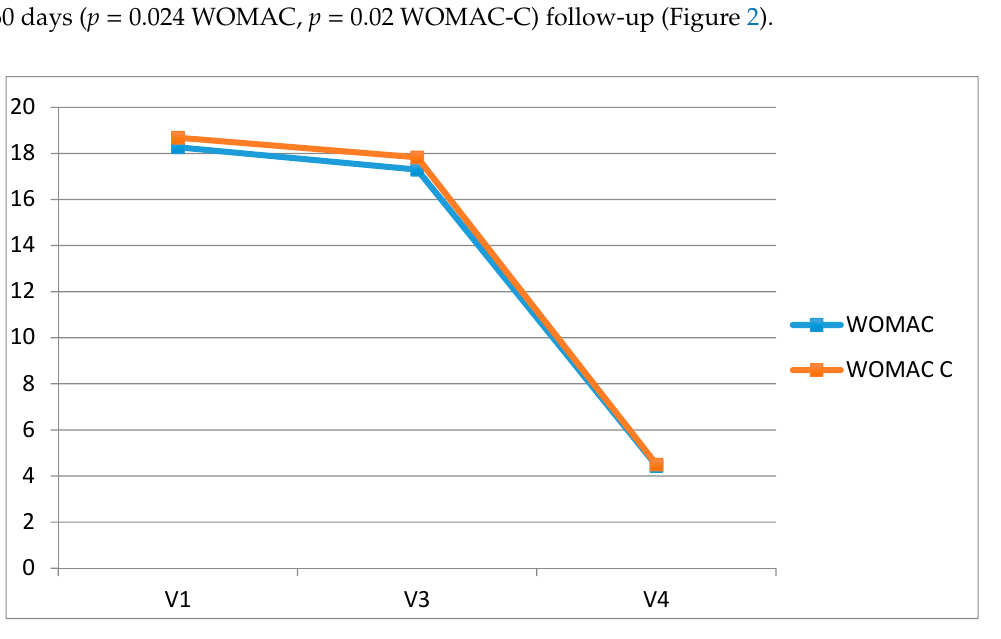
Figure 2. The Western Ontario and McMaster Universities Osteoarthritis Index (WOMAC) score and physical function subscale: 30 and 60 days follow-up.